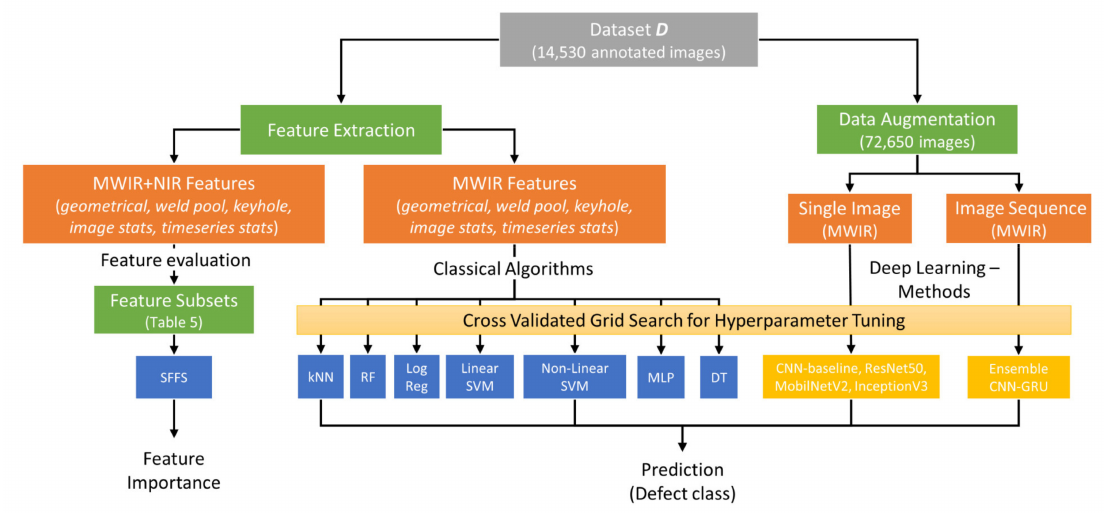
Figure 1. Schematic overview of the evaluation process established in this